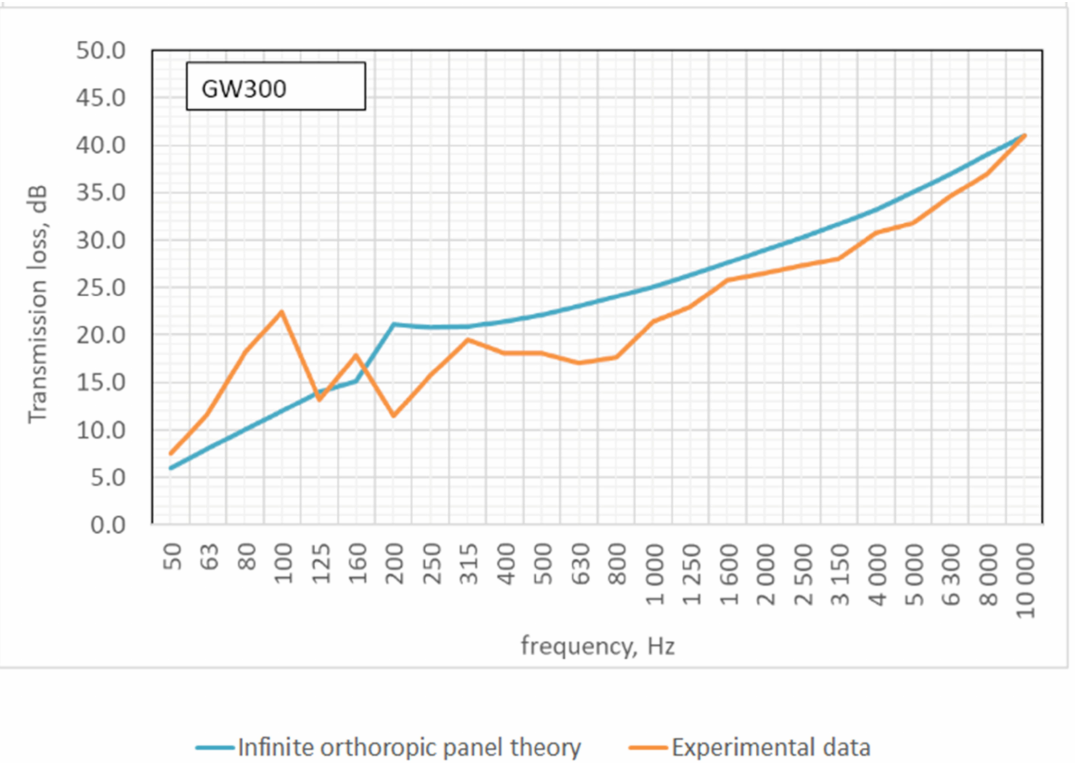
Figure 6. Measured (experimental) and predicted (theory) transmission loss (TL) for GW270 and GW300 PVC panels.